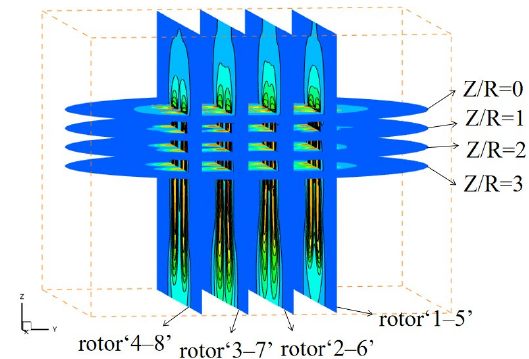
Figure 10. Cross sections of V8 Octorotor MAV.